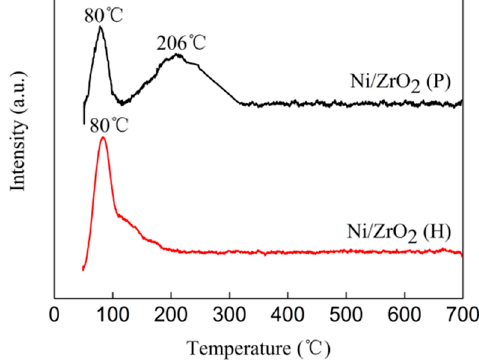
Figure 9. H 2 -TPD profiles of Ni/ZrO 2 catalysts.